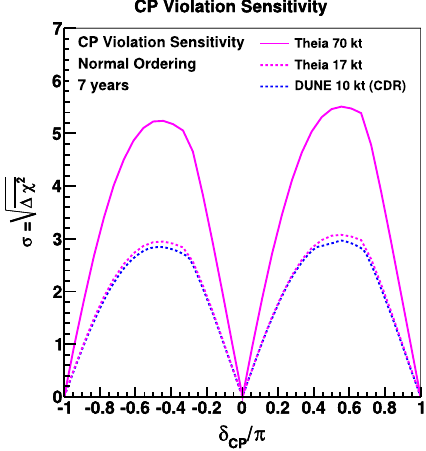
25 WCD detector (pink dashed). Seven years of exposure to the LBNF beam with equal running in neutrino and antineutrino mode is assumed. LArTPC sensitivity is based on detector performance described by